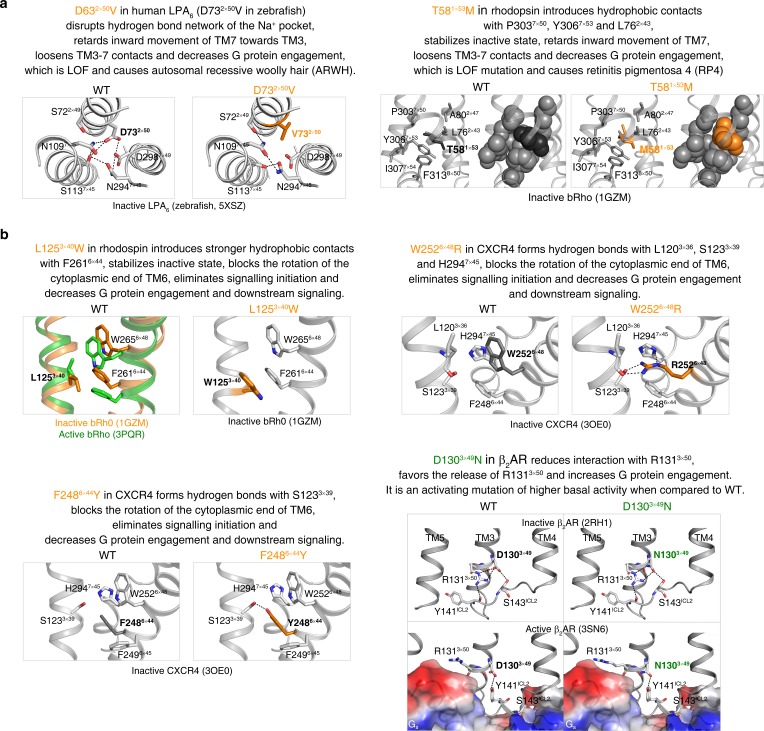
The common activation pathway can be used to mechanistically interpret disease-associated mutations and CAMs/CIMs.(a) Pathway-guided mechanistic interpretations of two disease mutations. (b) Pathway-guided mechanistic interpretations of four CAMs/CIMs.